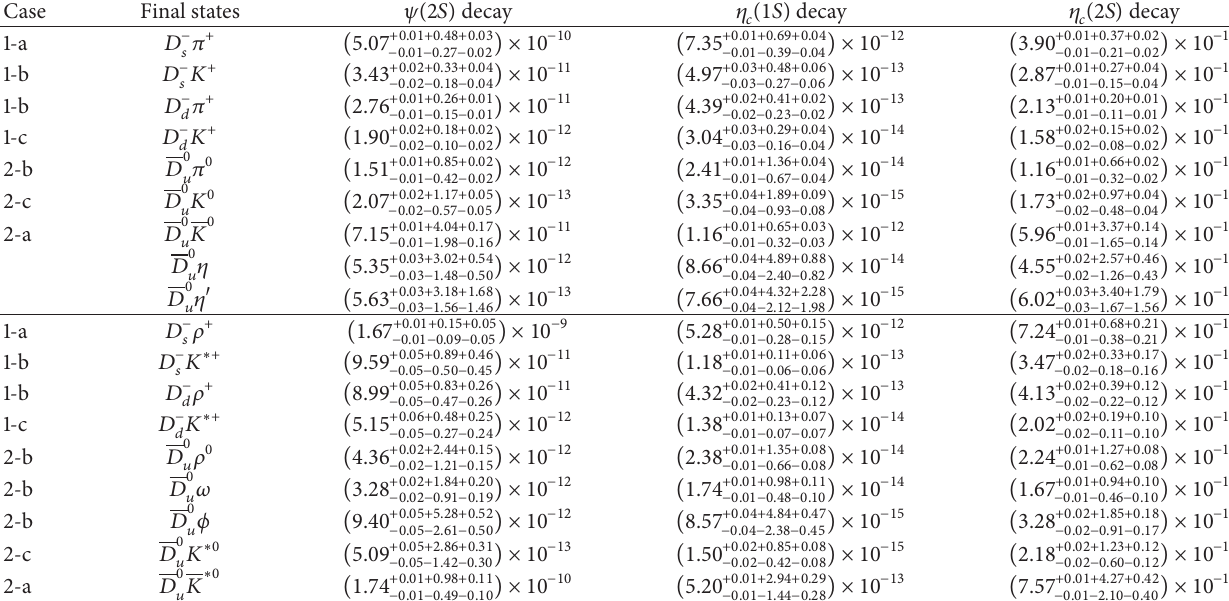
Table 6: Branching ratios for the nonleptonic two-body 𝜓(2𝑆) , 𝜂 𝑐 (1𝑆) , and 𝜂 𝑐 (2𝑆) weak decays, where the uncertainties come from the CKM parameters, the renormalization scale 𝜇 = (1 ± 0.2)𝑚 𝑐 , and hadronic parameters including decay constants and Gegenbauer moments, respectively.